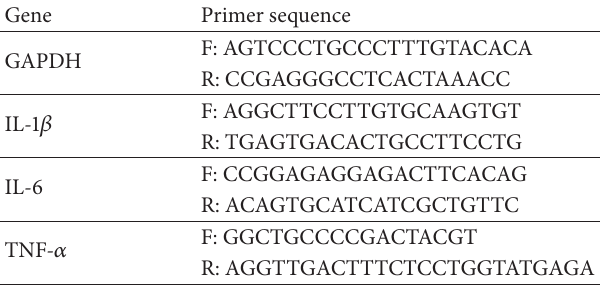
Table 1: Primers for